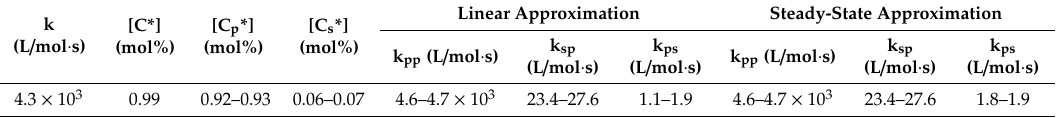
Table 2. Estimation of kinetic parameters based on the first-order Markovian statistics a .